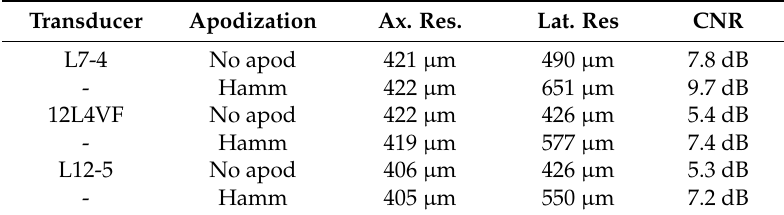
Table A2. Axial and lateral resolution, and CNR by angular weighted Lu’s-fk and Stolt’s-fk (range ±20°).